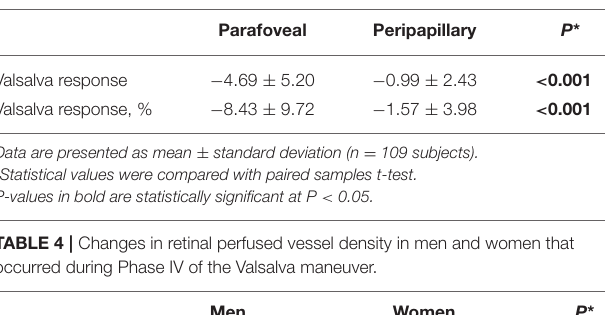
TABLE 4 | Changes in retinal perfused vessel density in men and women that occurred during Phase IV of the Valsalva maneuver.